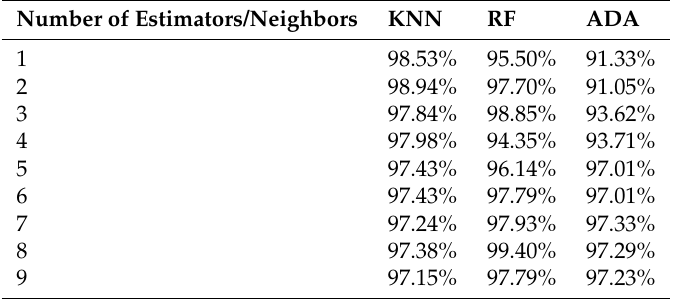
Table 4. Results of correctly classified instances for the meta-classifiers and KNN (with mean accuracy on the test datasets). ADA, AdaBoost.